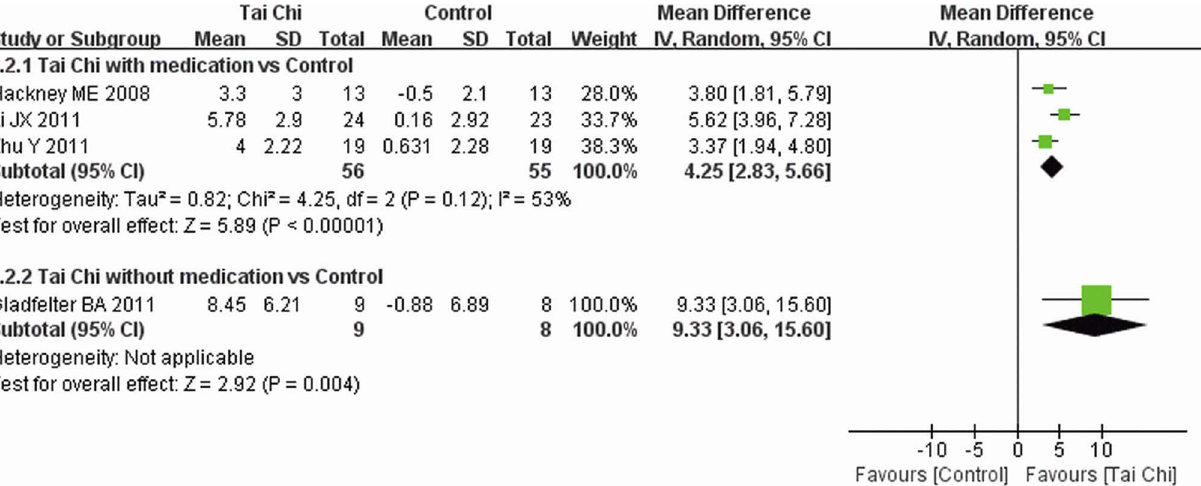
Figure 4. The effect of Tai Chi on BBS score. Subgroup analysis was performed according to whether or not medications were included in the intervention. A random model was used to address the high heterogeneity. BBS, Berg Balance